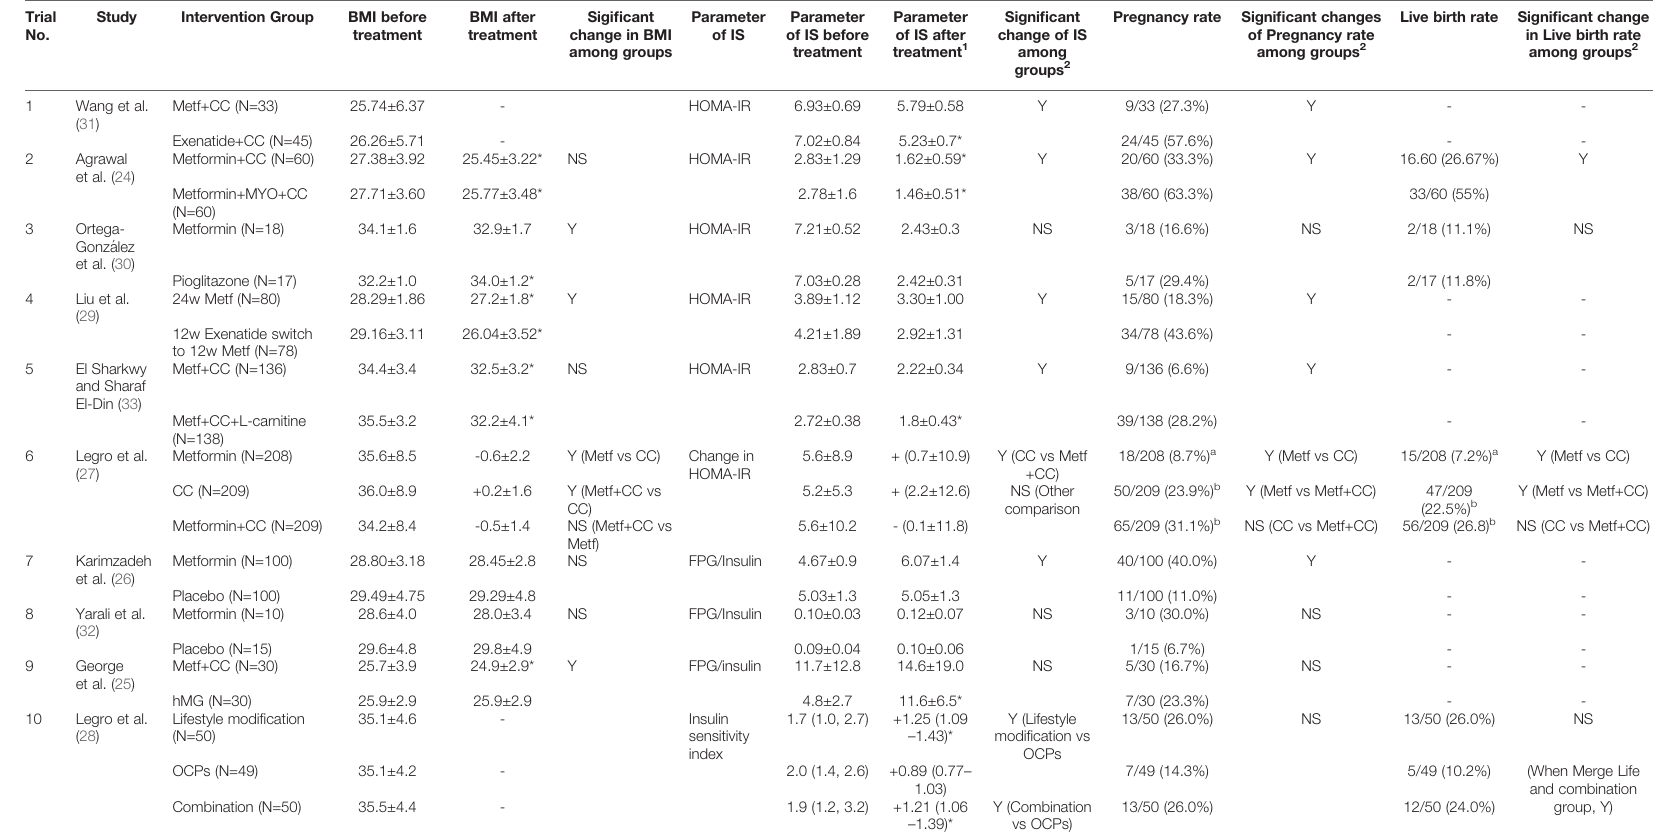
TABLE 2 | The pre- and post- BMI, insulin sensitivity parameters in the RCTs and pregnancy rate and live birth rate in the included RCTs. Trial